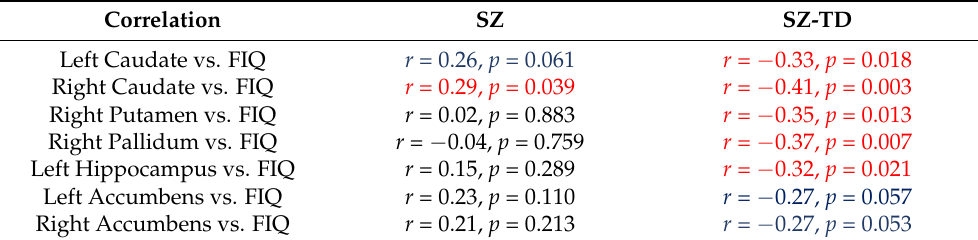
Table 5. Correlations between subcortical volumes and behavior in SZ and SZ-NT.